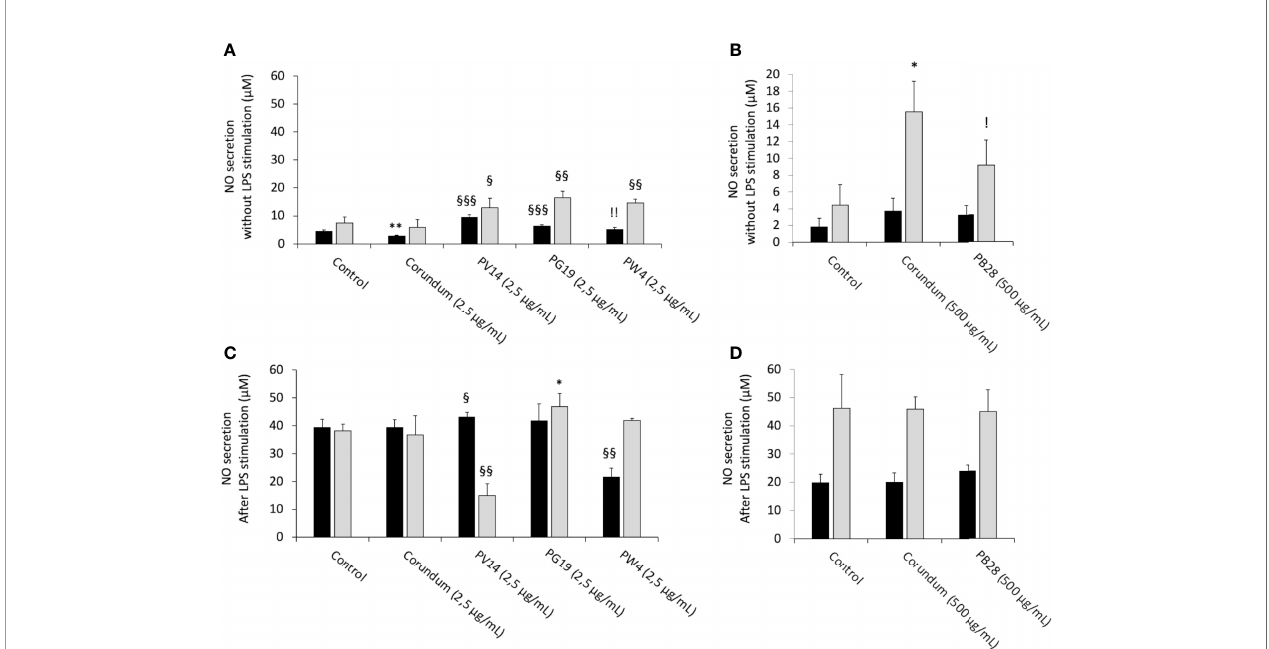
FIGURE 9 | NO secretion. Black bars: acute exposure (24 hours). Grey bars: exposure for 24 hours followed by a 3-day post-exposure recovery period. Panel (A) NO secretion without LPS stimulation. Conditions with 2.5 µg/ml of particle suspension. Panel (B) NO secretion without LPS stimulation. Conditions with 500 µg/ml of particle suspension. Panel (C) NO secretion with LPS stimulation. Conditions with 2.5 µg/ml of particle suspension. Panel (D) NO secretion with LPS stimulation. Conditions with 500 µg/ml of particle suspension. Signi fi cance of symbols: *: different from negative control only; §: different from both negative and corundum controls;!: different from corundum control only. Number of symbols: 1: p < 0.05; 2: p < 0.01; 3: p <